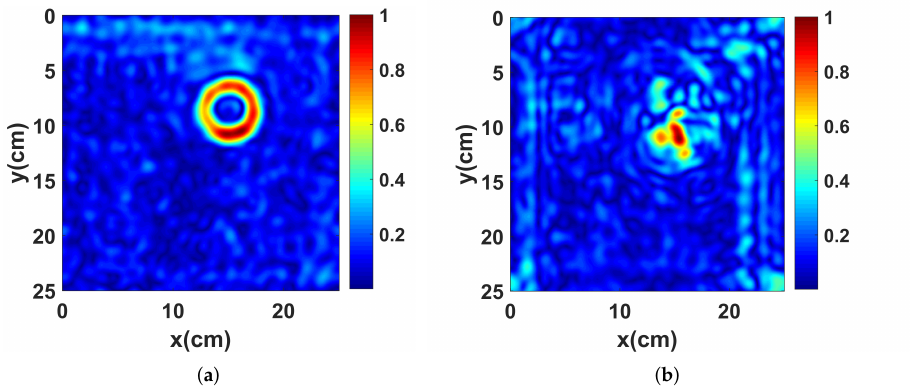
Figure 5. HSR images obtained from the standard autoencoder with double the amount of training data. ( a ) Autoencoder result of Scene I. ( b ) Autoencoder result of Scene II.